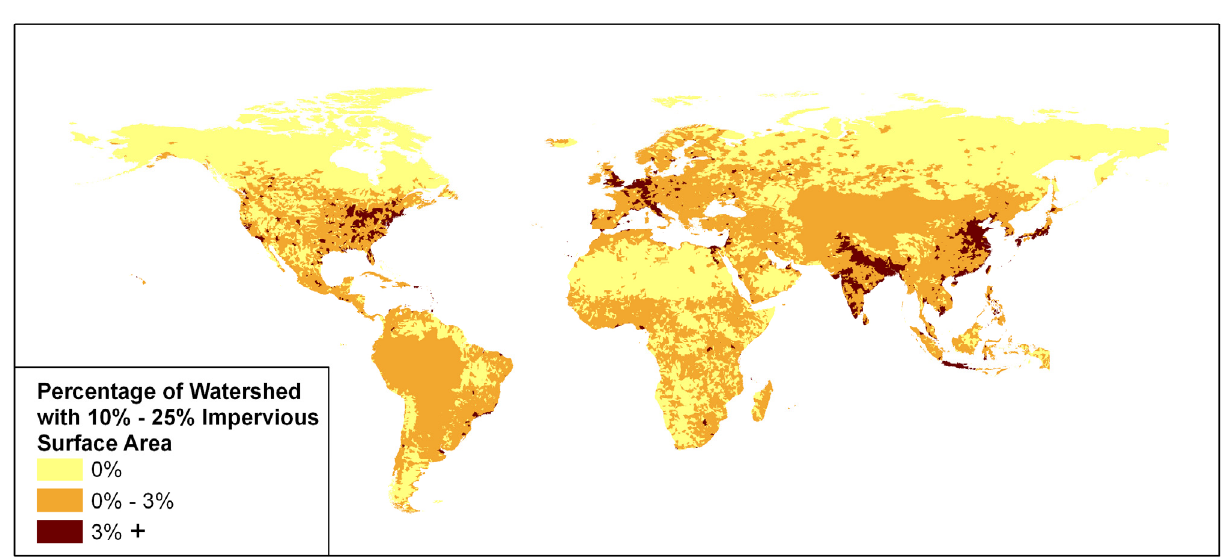
Figure 11. Percentage of watershed area in the impacted category - with 10-25% of constructed impervious surface area. Note that the Hydro 1K drainage basins used in the assessment does not include the watersheds of Australia.